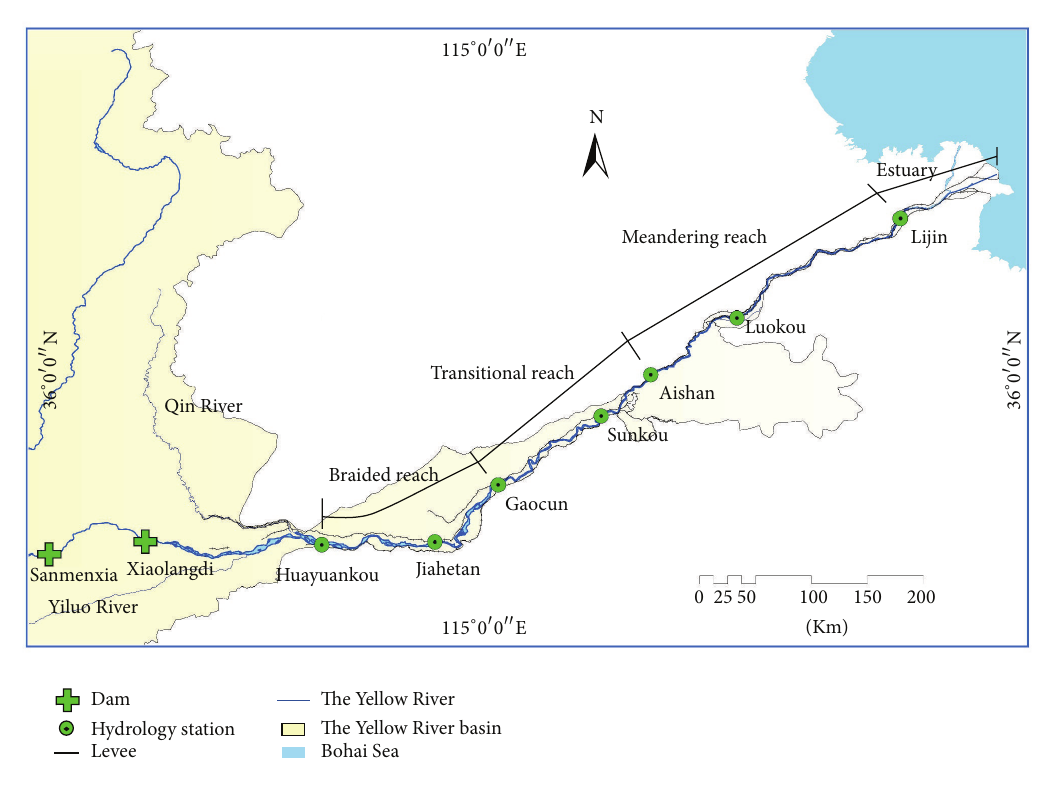
Figure 2: Map of the Lower Yellow River.